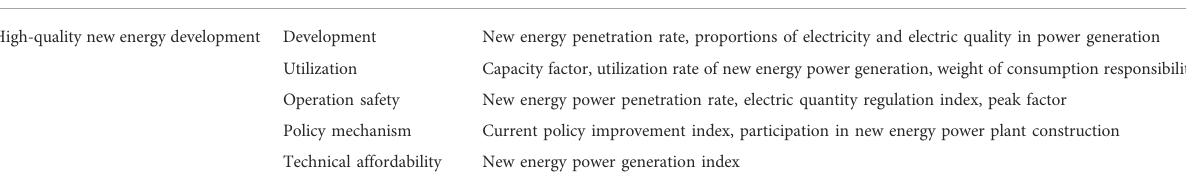
TABLE 4 High-quality new energy development evaluation indicator